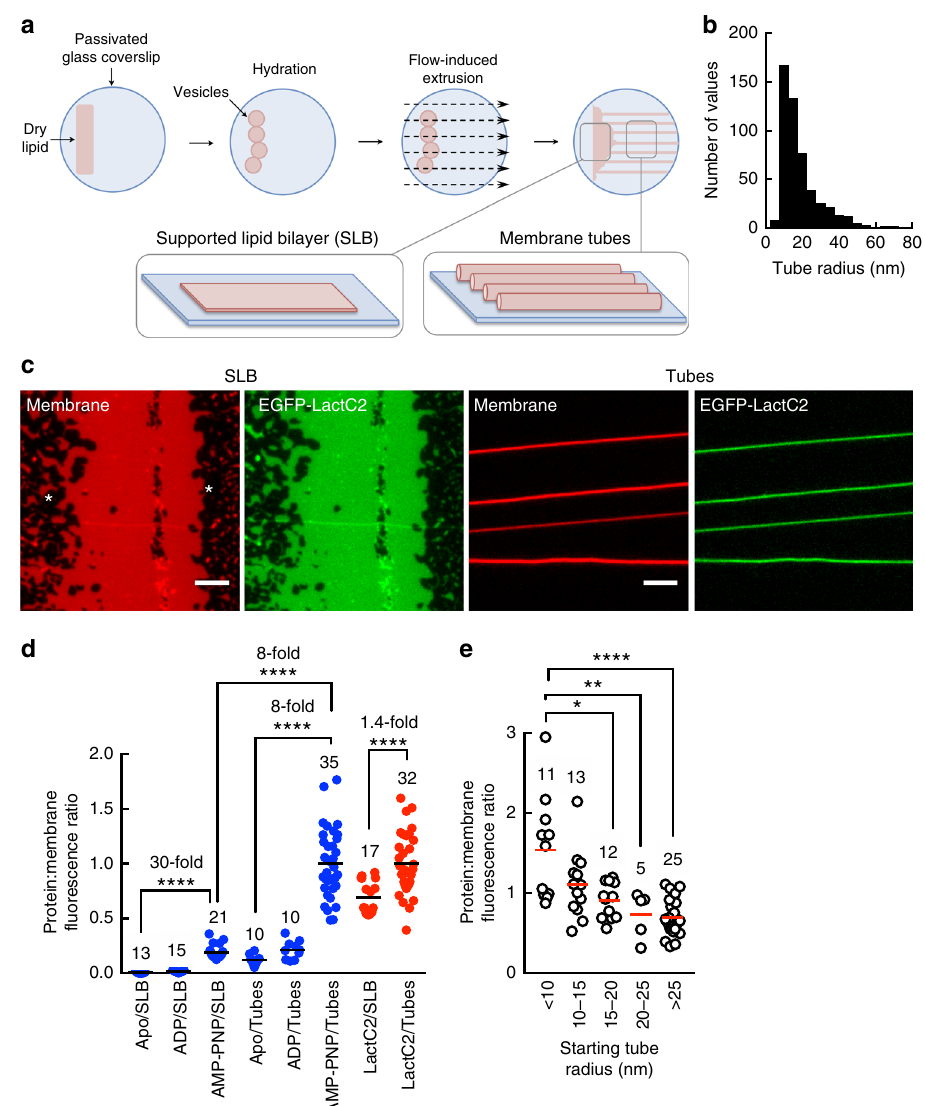
Fig. 3 ATP- and curvature-sensitive membrane binding of EHD1. a Schematic of generation of membrane templates used in the study. b Distribution of tube radii from fi ve independent preparations of templates. c Representative fl uorescence micrographs showing distribution of EGFP-LactC2 on SLBs and tubes. Asteriks mark the bare glass surface. Scale bars = 5 μ m. d Protein:membrane fl uorescence ratios of EHD1-EGFP with various nucleotides (blue) and GFP- LactC2 (red) for the indicated numbers of tubes and SLBs sampled. Black lines denote means. Statistical signi fi cance was assessed using Mann – Whitney test and **** P < 0.0001. e Protein:membrane fl uorescence ratios of AMP-PNP-bound EHD1-EGFP on tubes of varying starting sizes for the indicated numbers of tubes. Red lines denote means. Statistical signi fi cance was assessed using Mann – Whitney ’ s two-tailed test and * P = 0.010, ** P = 0.005, **** P <